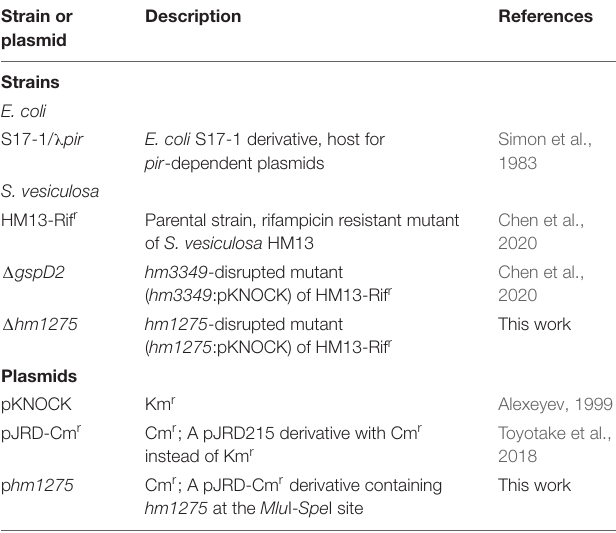
TABLE 1 | Bacterial strains and plasmids used in this study.